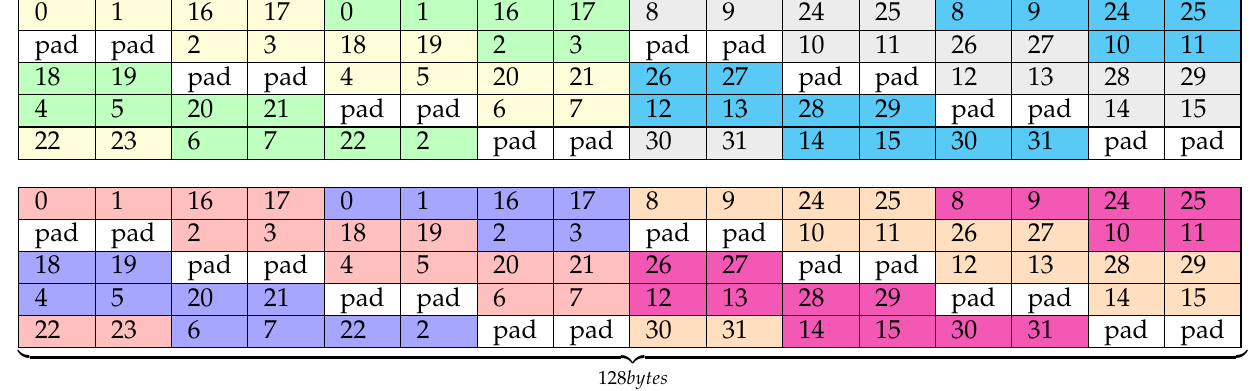
Figure 6. optSTS64 layout.